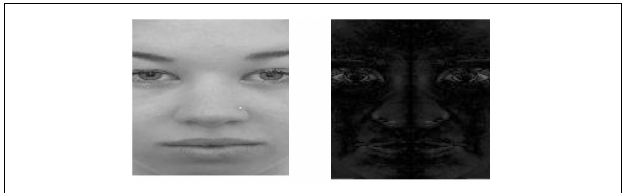
FIGURE 3 | Left : Original normalized face image, Right : D-face.